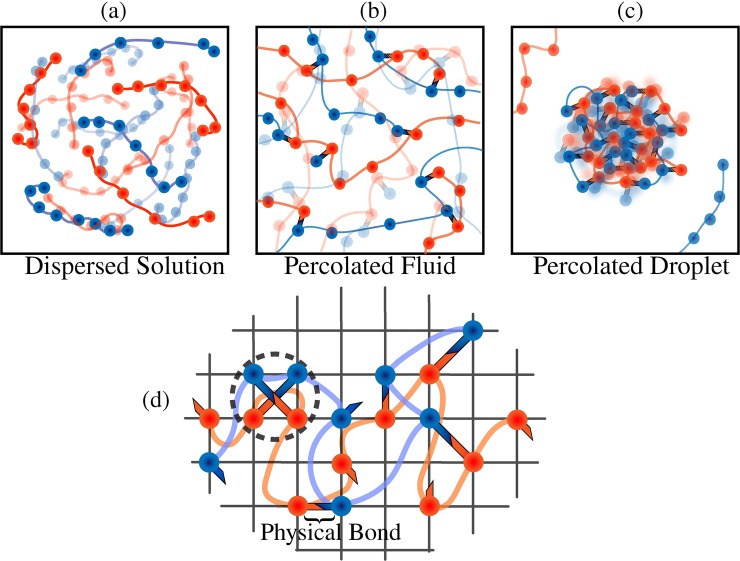
Characteristic phases in the stickers and spacers formalism.(a) Dispersed solution phase where the polymers are uniformly mixed in solution. (b) Percolated fluid wherein the polymer chains form a percolated, system-spanning network through physical crosslinks among stickers results. (c) Droplet wherein network formation also causes the polymers to form condensed phases. (d) Two-dimensional representation of the LASSI architecture. The beads with arms denote stickers where arms denote that the monomers are capable of orientational interactions, and the curved lines connecting the monomers represent phantom tethers, which are allowed to freely overlap (implicit spacer model). Different colors denote different sticker and spacer species respectively. Note that the physical bonds are allowed to overlap (dashed circle). For the rest of this work, physical bonds will not be labeled and will only be depicted as overlapping orientational arms.